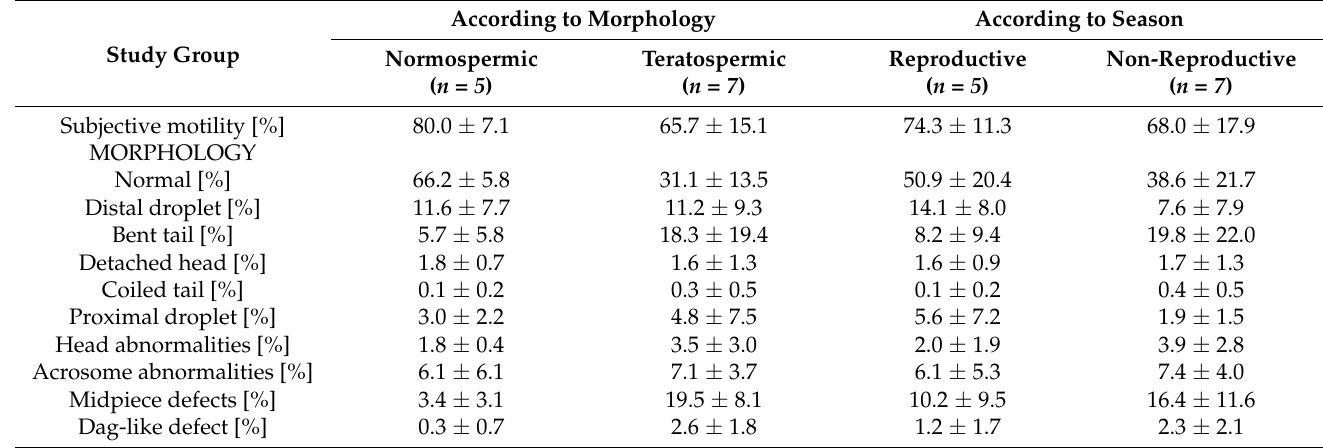
Table 2. Semen parameters of cats in Experiment I. Data presented as mean ± SD.